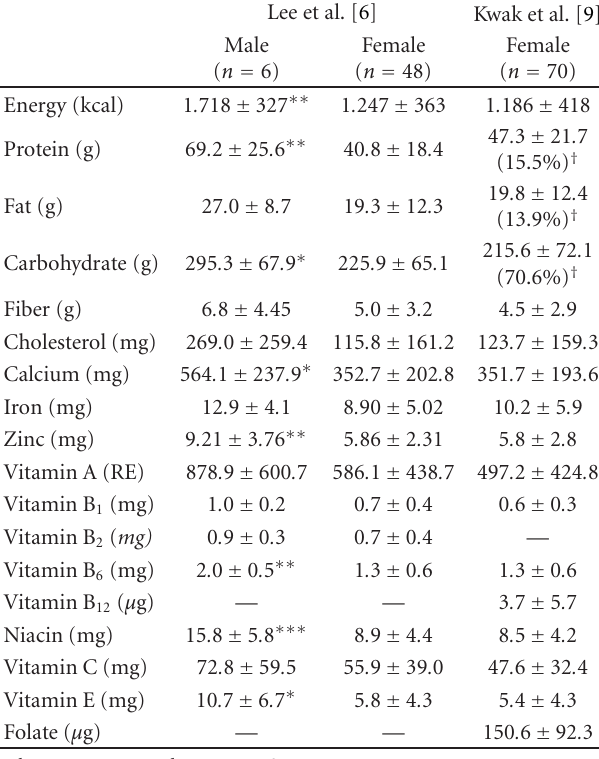
Table 3: Daily food intake and dietary balance and variety in Korean centenarians.